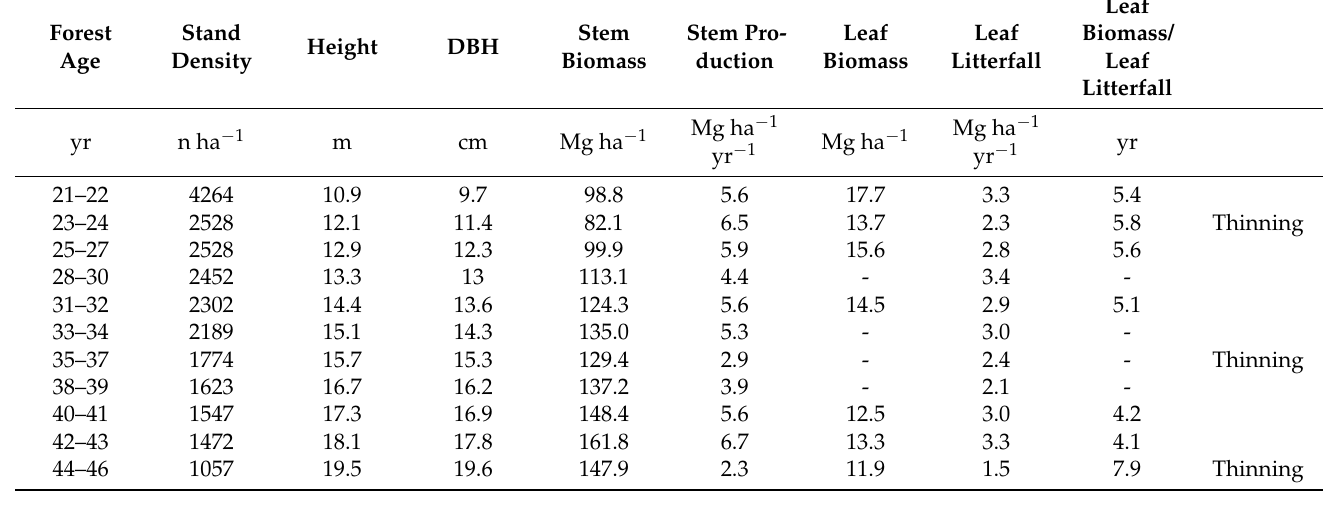
Table 3. Stem and leaf properties of hinoki cypress trees in the study site.